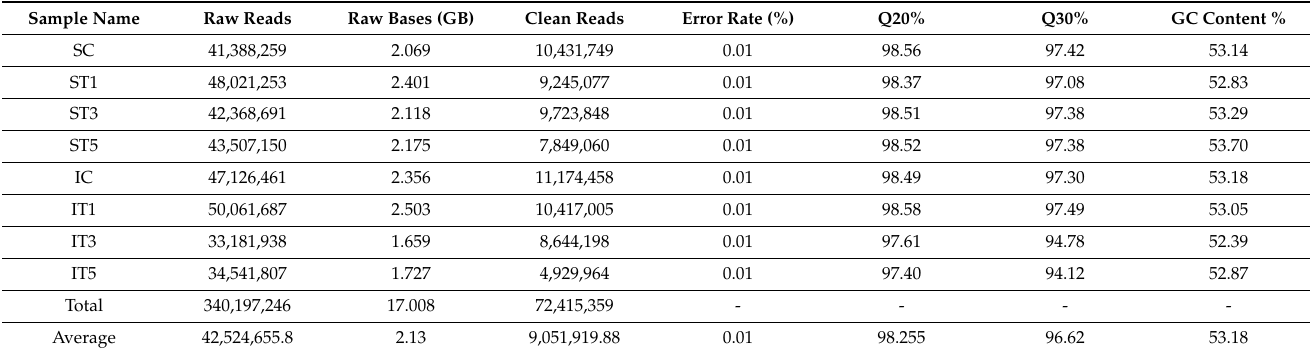
Table 1. Basic statistics of total raw and clean reads of small RNA sequencing (miRNA) data for control and low-light-treated samples of rice genotype Swarnaprabha (low-light-tolerant) and IR8 (low-light-sensitive).